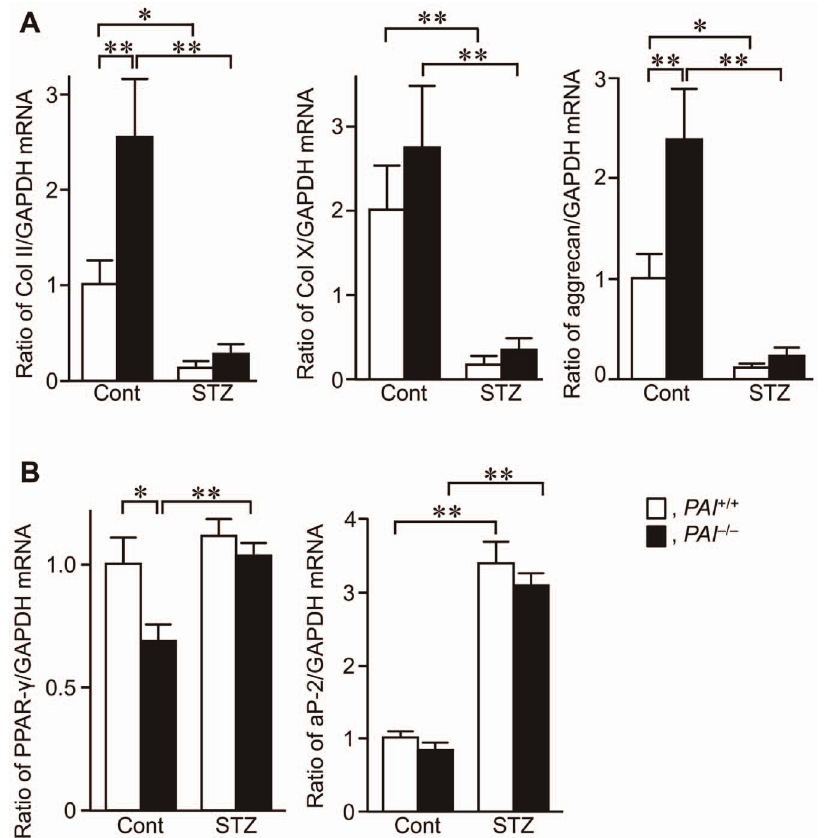
Figure 6. Effects of PAI-1 deficiency on chondrogenic or adipogenic differentiation during bone repair in female mice. (A) The levels of type II collagen (Col II), type X collagen (Col X), and aggrecan mRNA at the damaged site on day 7 after a femoral bone defect in female PAI-1 + / + and PAI-1 2 / 2 mice with or without STZ treatment. Data are expressed relative to GAPDH mRNA values, and are expressed as mean 6 SEM. * p , 0.05, ** p , 0.01 (n=5–7 in each group). (B) The levels of PPAR- c and aP-2 mRNA at the damaged site on day 7 after a femoral bone defect in female PAI-1 + / + and PAI-1 2 / 2 mice with or without STZ treatment. Data are expressed relative to GAPDH mRNA values, and are expressed as mean 6 SEM. * p , 0.05, ** p , 0.01 (n=5–7 in each group). Cont,